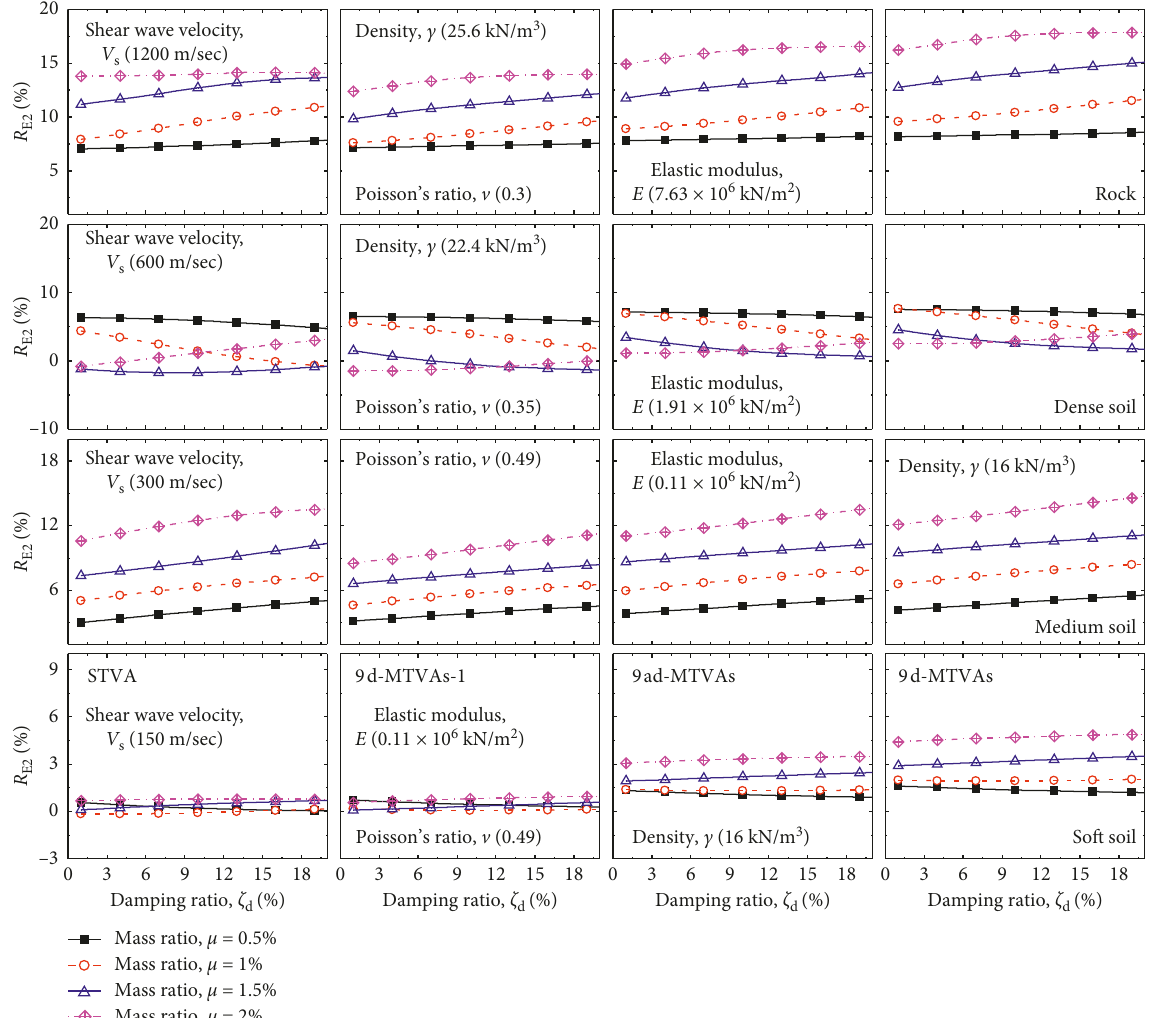
Figure 9: Variations of damping ratios ( ζ d ) for different mass ratios ( µ ) of the STVA, 9d-MTVAs-1, 9ad-MTVAs, and 9d-MTVAs installed on the chimney including SSI under Nahanni (1985) earthquake ground